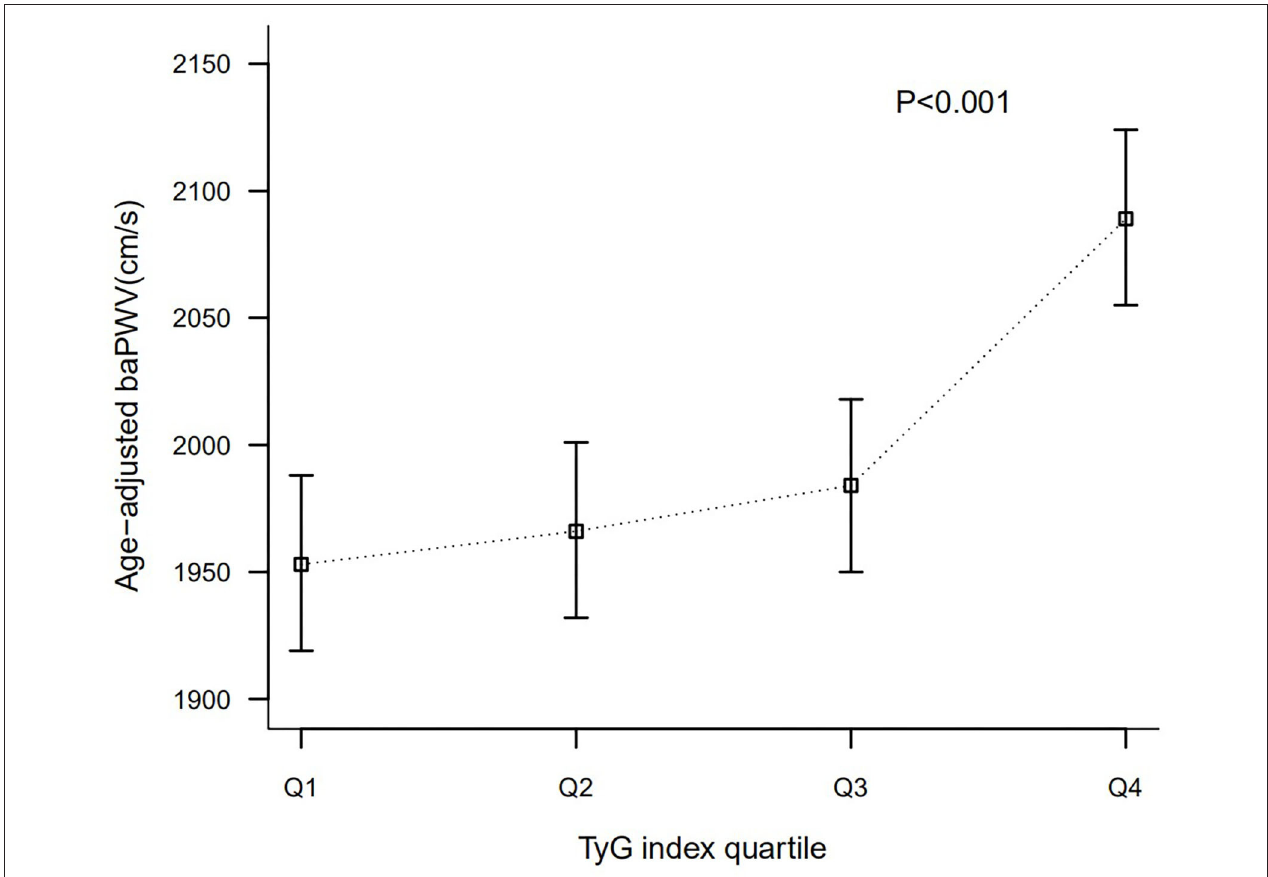
FIGURE 1 | Comparison of baPWV according to TyG index quartile after adjusted for